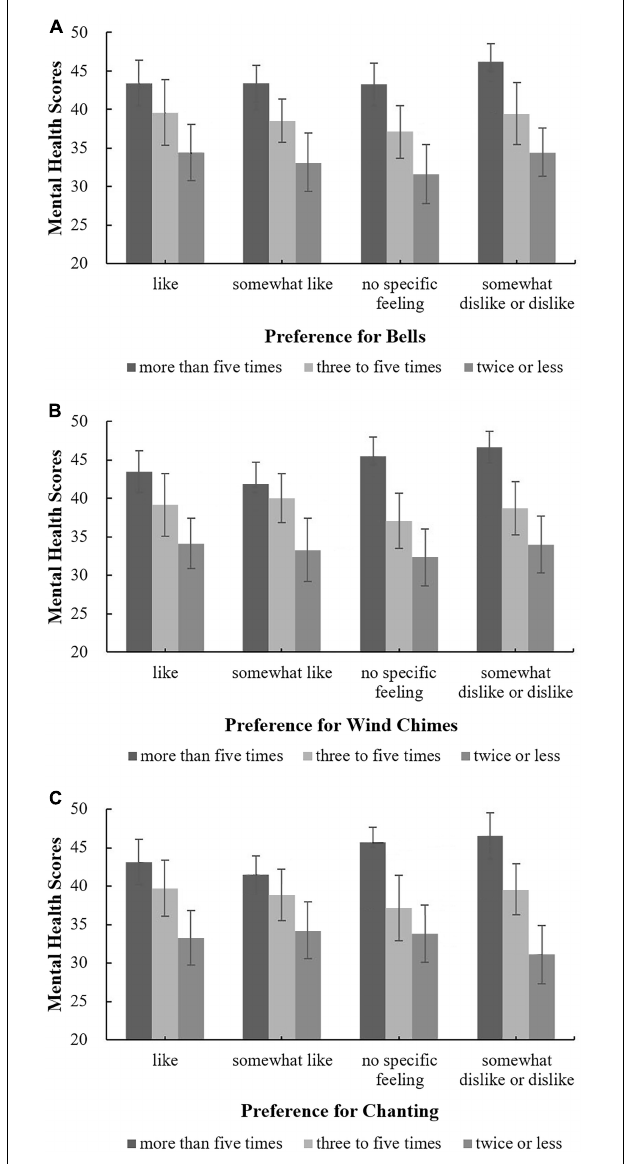
FIGURE 8 | The relationships between sound preferences and mental health under different frequencies. (A) Bells; (B) Wind chimes; (C) Chanting.